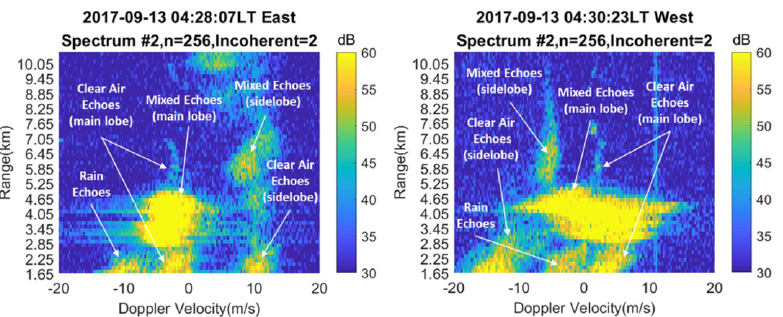
Figure 10. Time series of rainfall rate measured by a ground-based disdrometer co-located at the Chung-Li radar station.